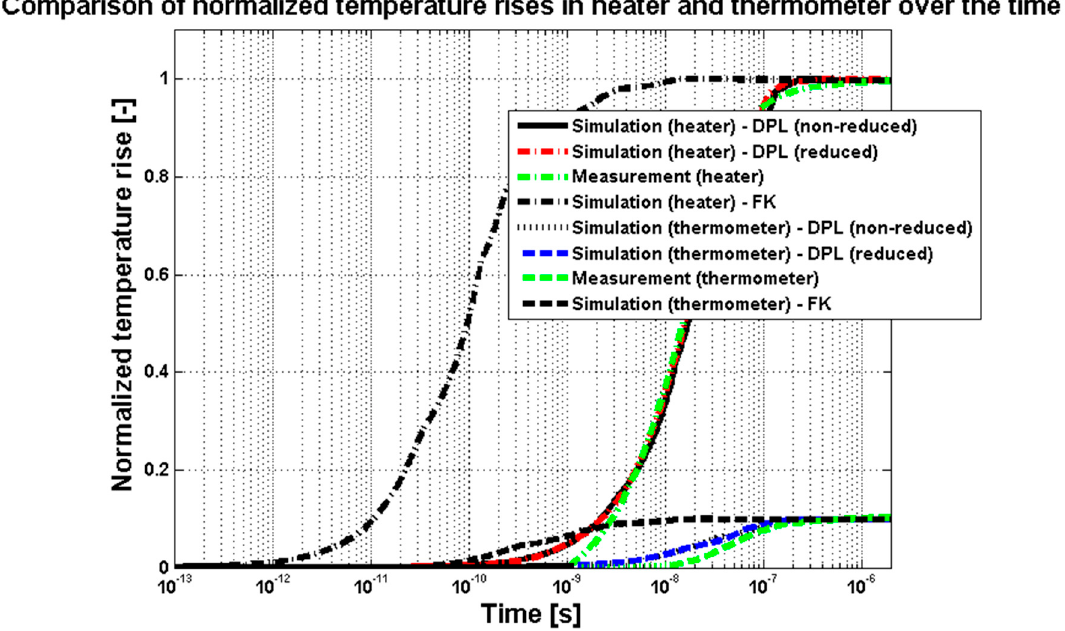
Figure 3. Comparison of normalized average temperature rises over the time in the platinum heater and the temperature sensor obtained using the reduced and non-reduced Dual-Phase-Lag (DPL) model, Fourier–Kirchhoff (FK) model, and measurements .